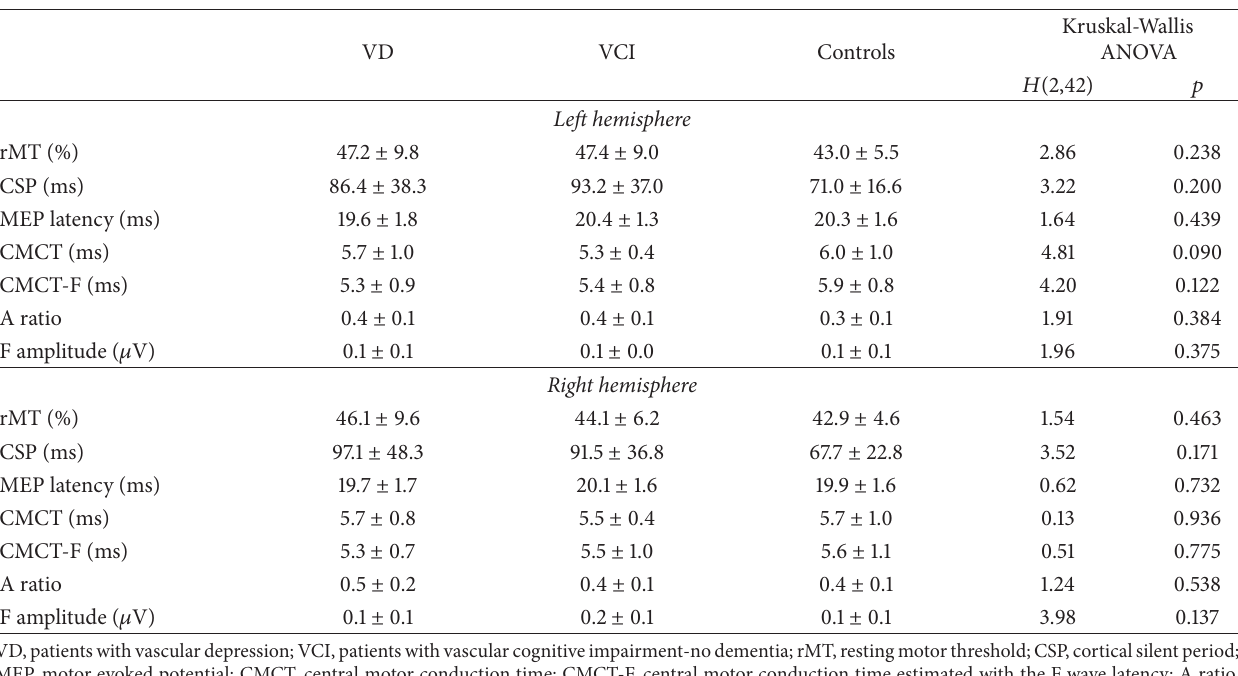
Table 2: Single-pulse TMS parameters obtained from patients and controls at baseline.